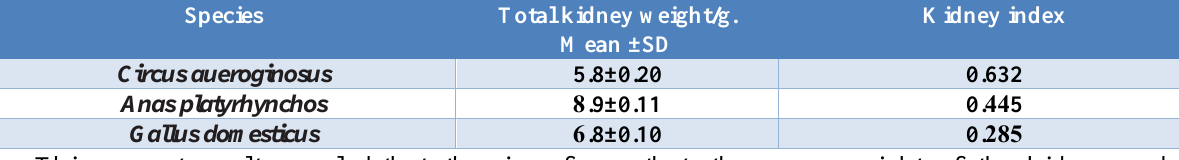
Table, 2: illustrated the total weights of kidneys (left and right) (n=5 in each species)(N=15).